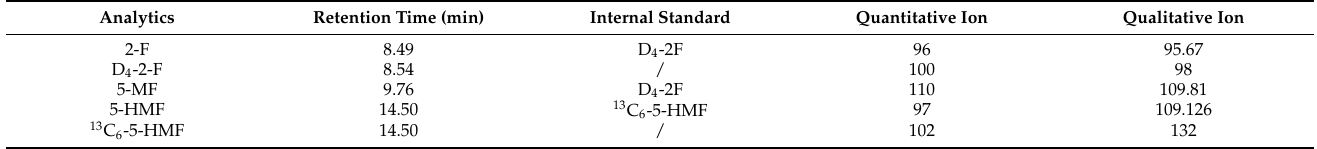
Table 1. The selected quantification and fragmented ions used in the